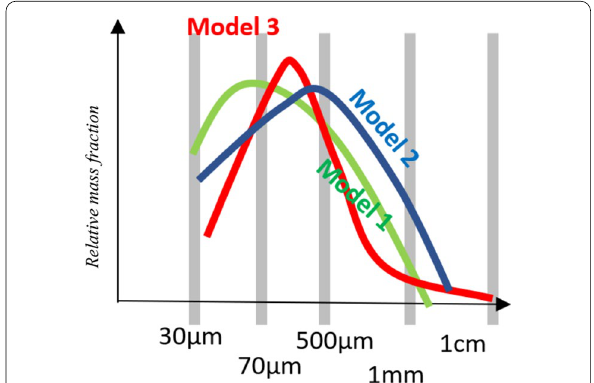
Fig. 4 Conceptual model of particle size distributions of regolith on Phobos